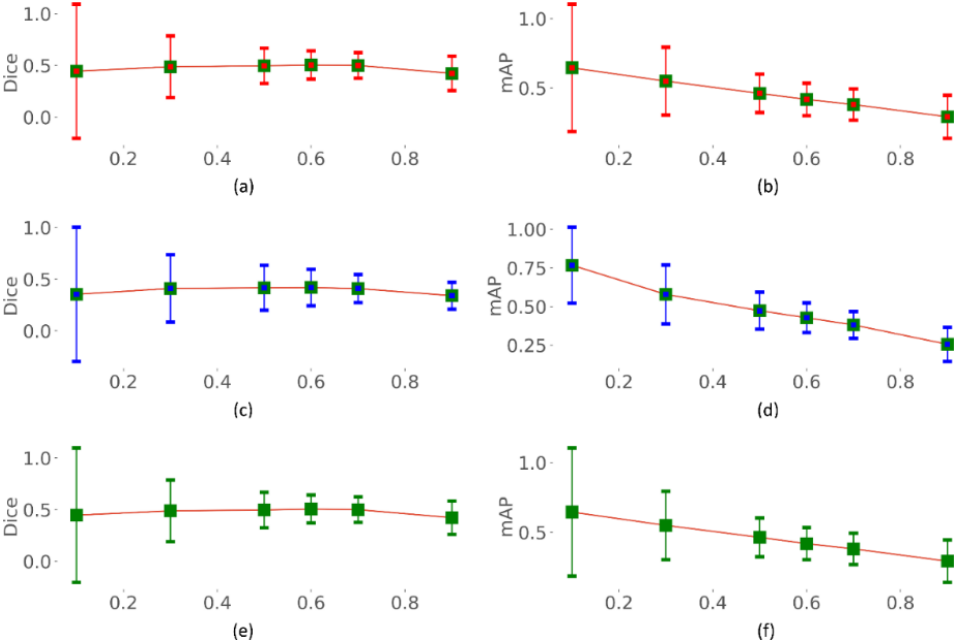
Figure 8. Dice index and mAP measured for varying values of τ . ( a , b ) using aleatoric uncertainty; ( c , d ) using epistemic uncertainty; and ( e , f ) using total (aleatoric + epistemic) uncertainty.